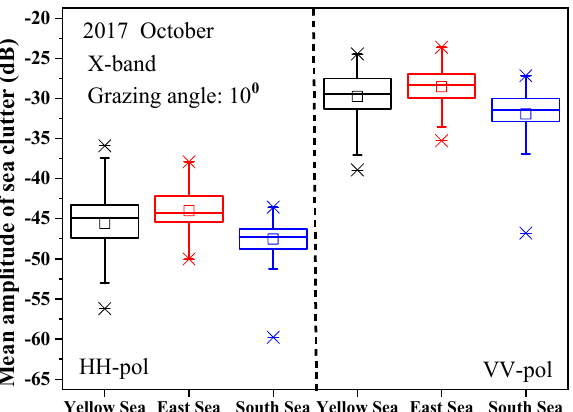
Figure 16. Statistics of mean amplitude characteristics under different polarizations in different sea areas.